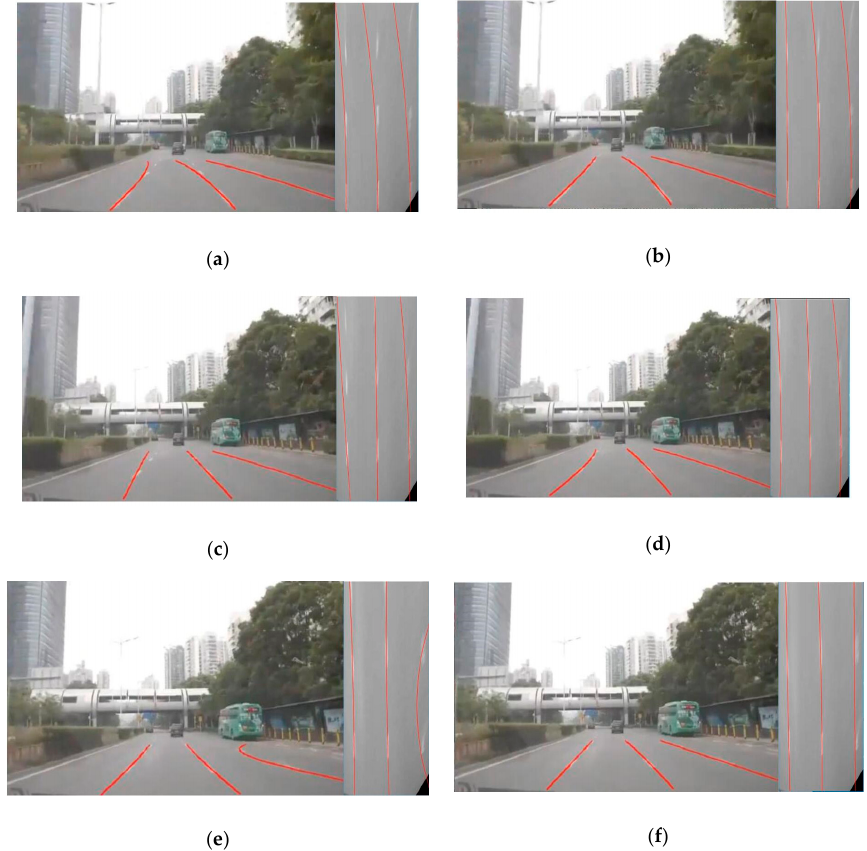
Figure 12. The comparative result of traditional RANSAC and regional G-RANSAC. ( a , c , e ) fitting results of the traditional RANSAC, ( b , d , f ) fitting results of the regional G-RANSAC.